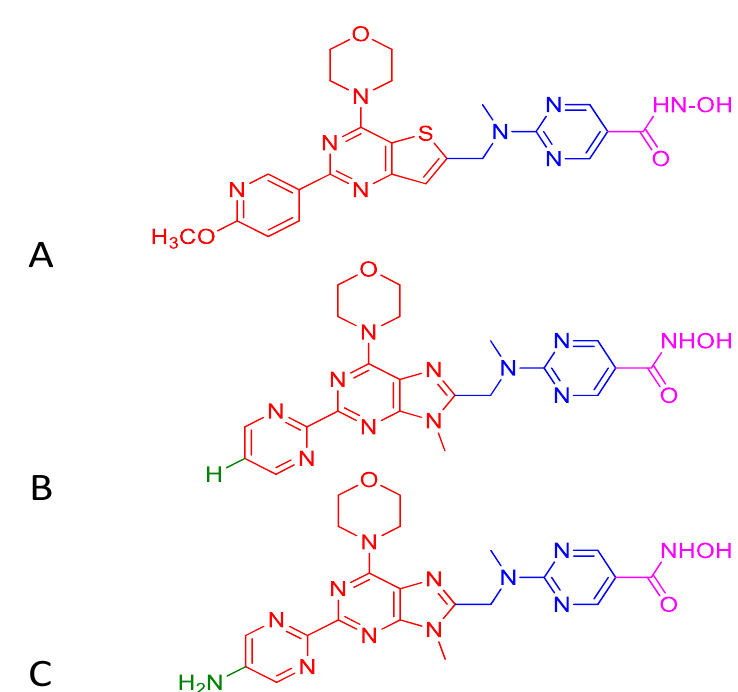
Figure 6. Structure of CUDC-907 ( A ) and the two active analogs ( B ) and ( C ). Morpholinopyrimidine moiety of PI3K pharmacophore (shown in red) in Figure ( A ) is integrated to HDAC inhibitory hydroxamic acid functionality (shown in magenta) through a linker (shown in blue). In Figure ( B , C ), morpholinopyrimidine moiety shown in Figure ( A ) is replaced with morpholinopurine (shown in red). The analog having a pyrimidine with hydrogen (green) at the C-2 position of the morpholinopurine moiety is shown in Figure B . The analog having a pyrimidine with an amino group (green) at the C-2 position of the morpholinopurine moiety is shown in Figure ( C ).